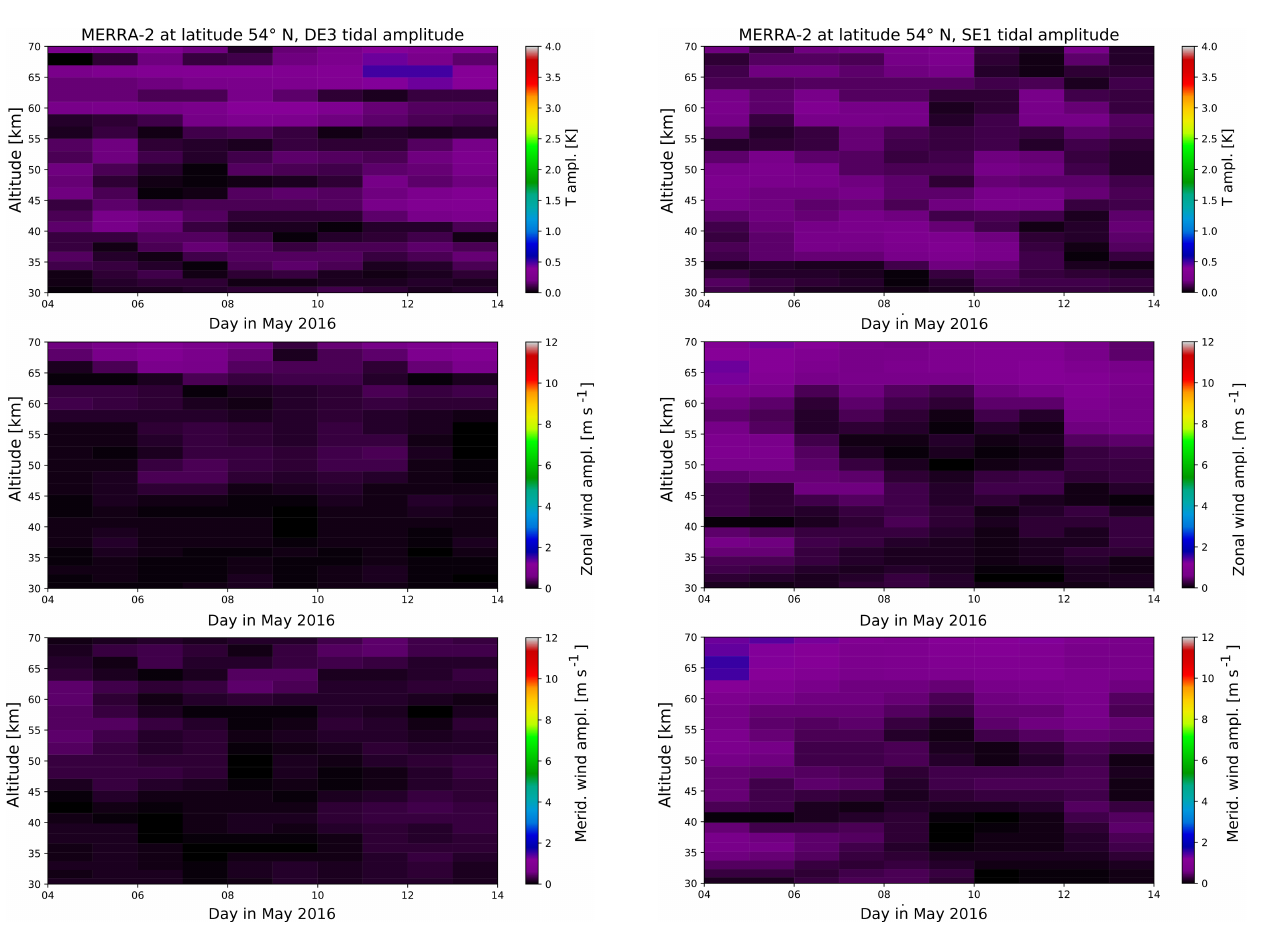
Figure A10. SE1 amplitude in temperature, zonal and meridional wind from global MERRA-2 fields at the latitude of 54 ◦